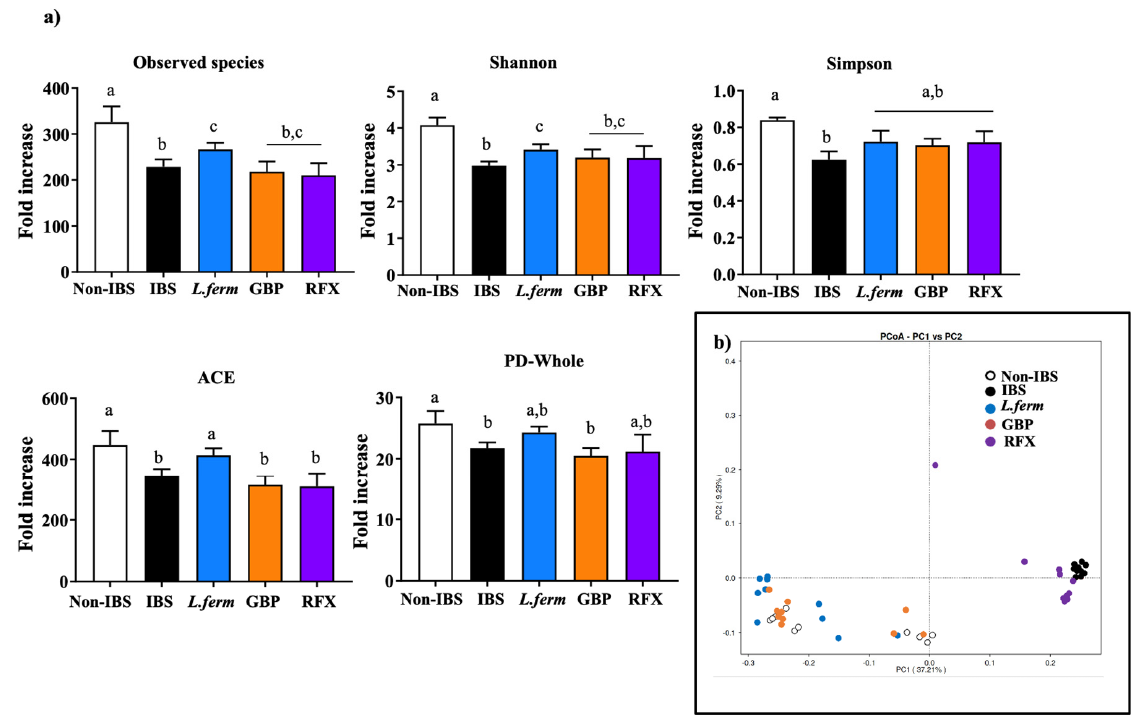
Figure 9. Impact of probiotic administration on microbiome diversity of DCA vehicle (Non-IBS), 4 mmol/L DCA (IBS), L. fermentum (10 9 CFU) ( L. ferm )-, Gabapentin at 70 mg/kg (GBP)- and Rifaximin at 150 mg/kg (RFX)-treated rats. ( a ) Alpha microbiota diversity indexes determined by Illumina sequencing: Observed species, Shannon and Simpson indexes, ACE and PD-Whole indicator. ( b ) β - diversity calculated by principal coordinate analysis score plot. Data are presented as mean ± SEM. Bars with different letters statistically differ ( p < 0.05).